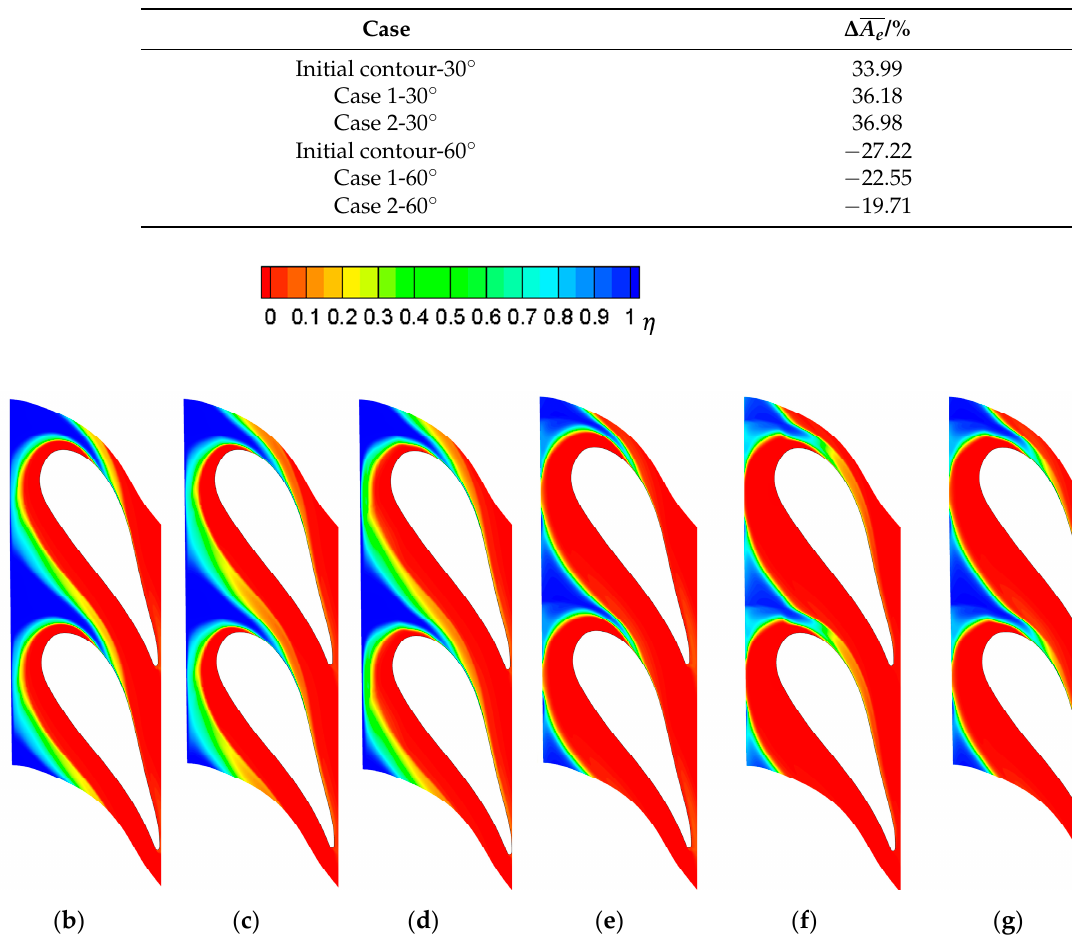
Figure 13. Film cooling effectiveness distributions on the endwall. ( a ) Initial contour. ( b ) Initial contour-30°. ( c ) Case 1-30°. ( d ) Case 2-30°. ( e ) Initial contour-60°. ( f ) Case 1-60°. ( g ) Case 2-60°.